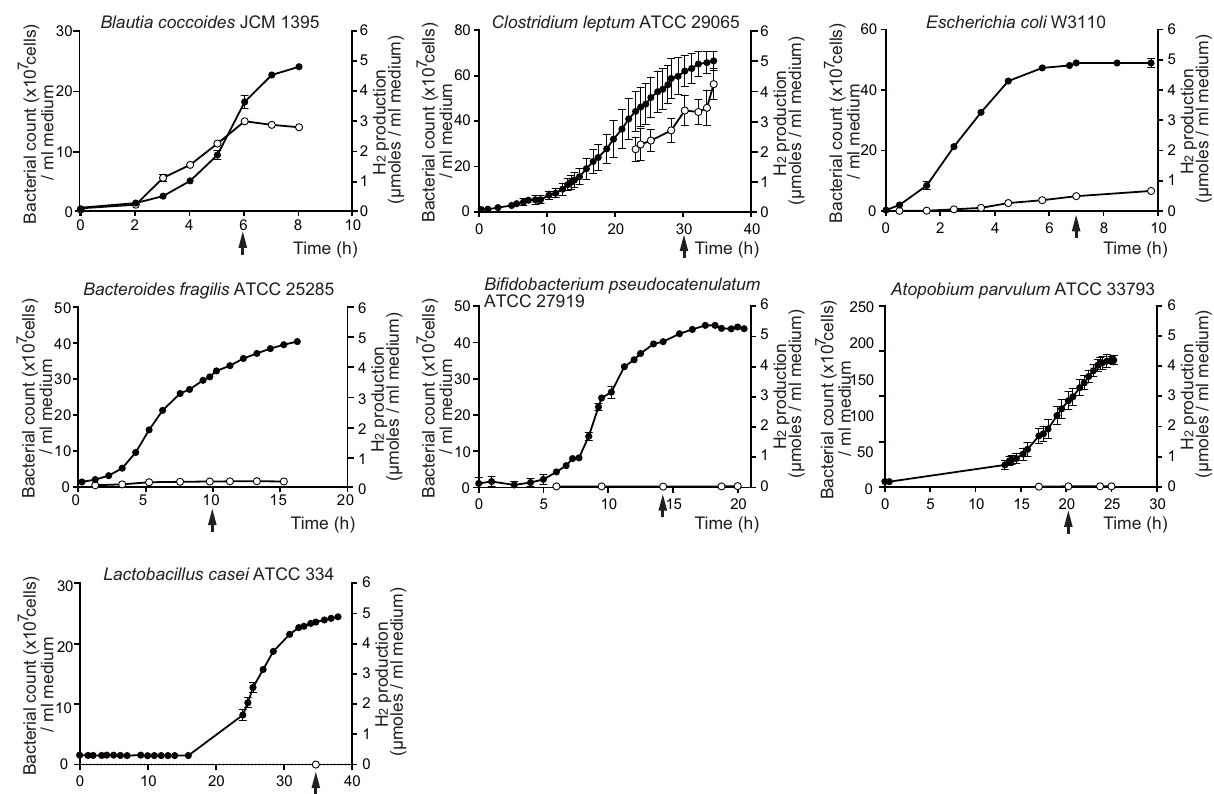
Fig 1. Temporal profiles of the number of bacteria (closed circles) and hydrogen production (open circles). The numbers of bacteria per ml culture medium are plotted on the left axis (closed circles). The hydrogen concentration was quantified by a gas chromatography, and the number of hydrogen molecules per ml culture medium was calculated and plotted on the right axis (open circles). Arrows point to the transition between the growth and stationary phases when the hydrogen concentration accumulated in the gaseous phase was used to calculate the hydrogen production. Note that scales on the right vertical axes are identical, whereas scales on the left vertical axes and on the horizontal axes are different. Mean and SD are indicated ( n = 3 or 4 culture tubes).